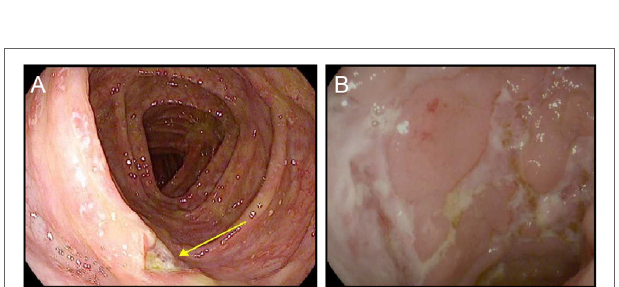
FiGURe 3 | Colitis associated with PD-1 blockade. (a,B) High resolution photograph of the colon from a patient with moderate to severe colitis associated with PD-1 blockade (a) or a patient with biopsy confirmed PD-1-blockade-associated microscopic colitis (B)